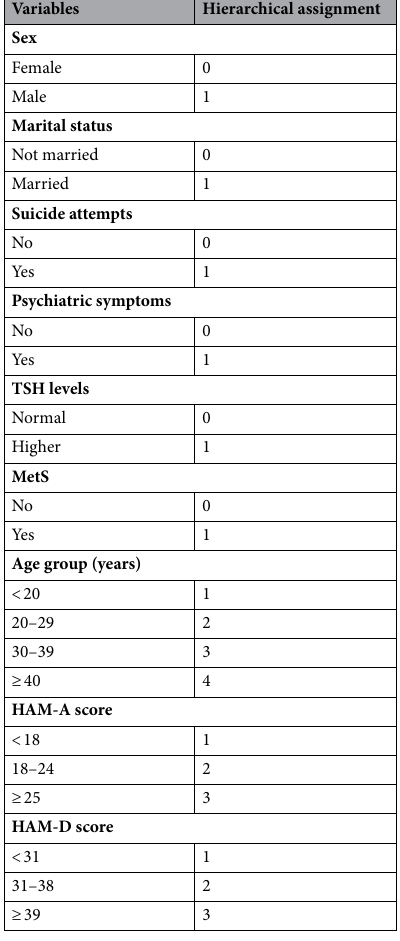
Table 2. Description table of hierarchical assignment of included influencing factors.